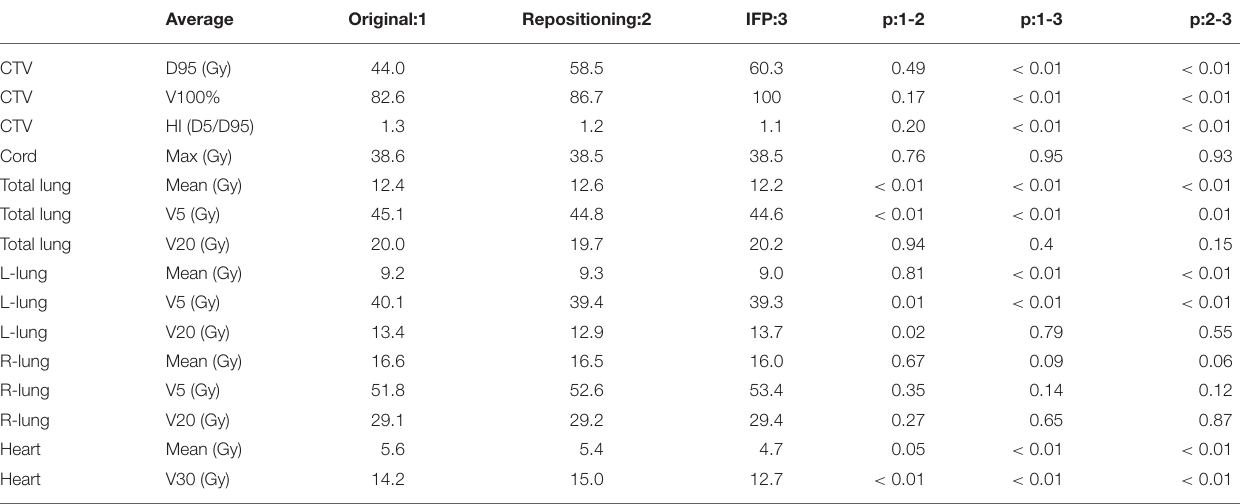
TABLE 3 | Average dosimetric parameters for the three scenarios (original plan, repositioning plan, and IFP plan) of the lung cases.